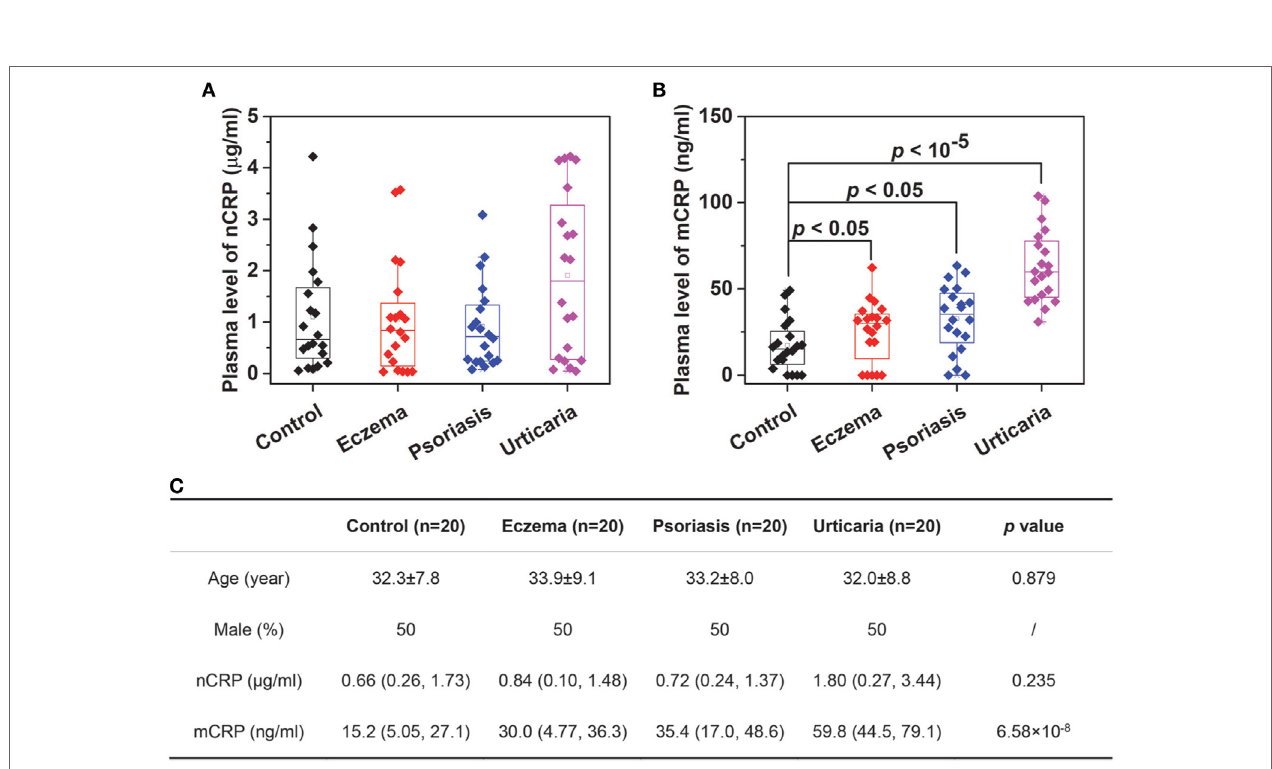
FigUre 2 | Adaptability of the assay. Monomeric CRP (mCRP) at the indicated concentrations in TBS buffer (a) or reference human sera (1:100) (B) were added to wells (Corning) coated with 1:1,000 CRP-8 mAb (clone 8), and the captured proteins were detected with a polyclonal CRP antibody from the BindingSite. The endogenous mCRP concentrations in the reference human sera were < 10 ng/mL and therefore was undetectable following 1:100 dilution. The Pearson’s correlation coefficients ( R ) were also indicated.